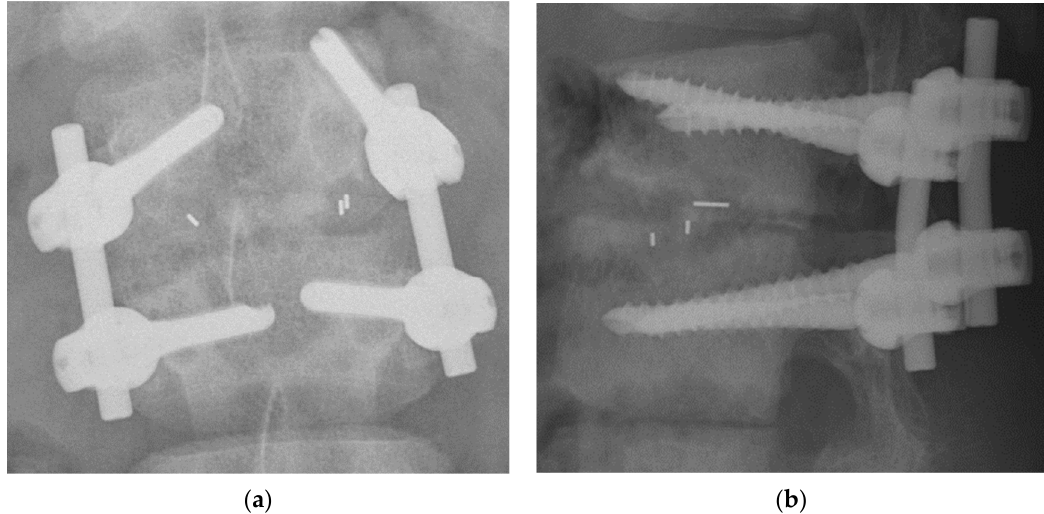
Figure 1. Radiographs after L1–2 TLIF surgery of a 64-year-old woman with ESRD. ( a ) Pedicle screw loosening on the left side of the L1. ( b ) Grade 4 fusion status and grade 3 cage subsidence with bone resorption around cage. TLIF, transforaminal lumbar interbody fusion; ESRD, end-stage renal disease.